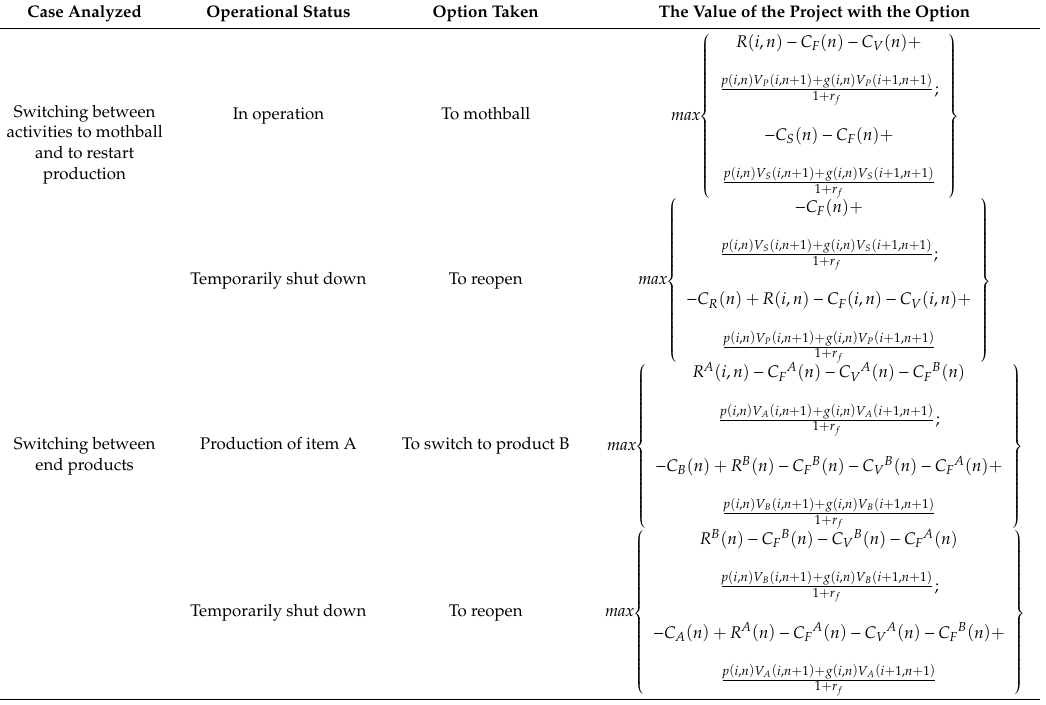
Table 1. Payo ff functions for switching options (source: own study based on [39,40]). Case Analyzed Operational Status Option Taken The Value of the Project with the Option